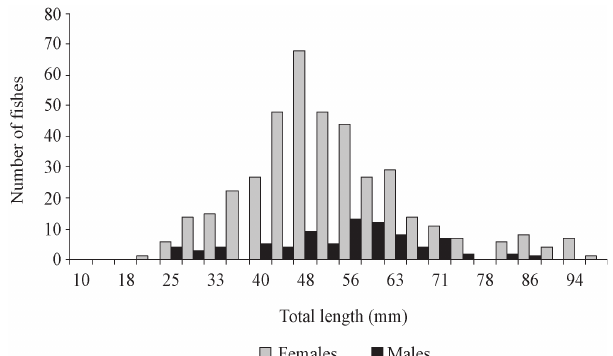
Fig. 2. Length frequency distribution by sex for Poecilia sphenops at Emiliano Zapata Reservoir, Mexico.